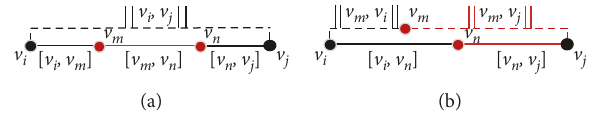
Figure 4: Illustration of Theorem 1. (a) Internal distance computation. (b) External distance computation.